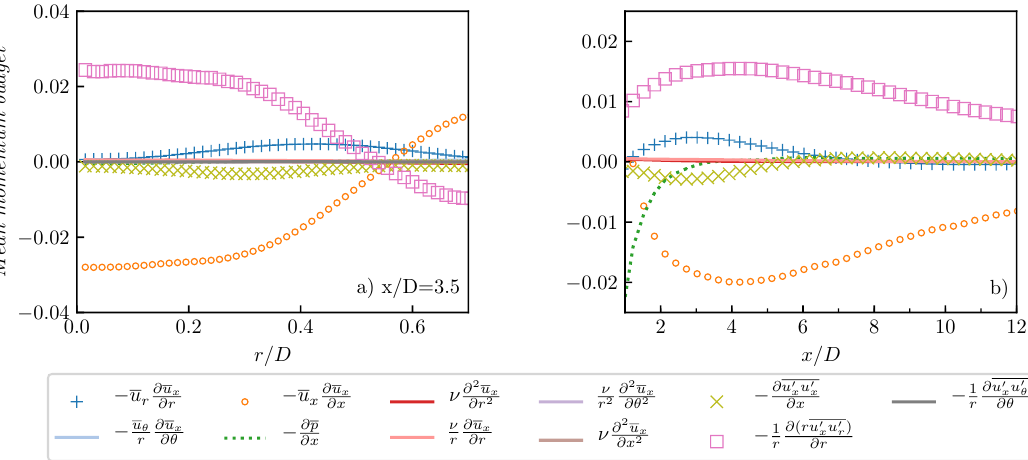
Figure 15. Budgets of the mean momentum Equation (22) along ( a ) radial direction and ( b ) streamwise